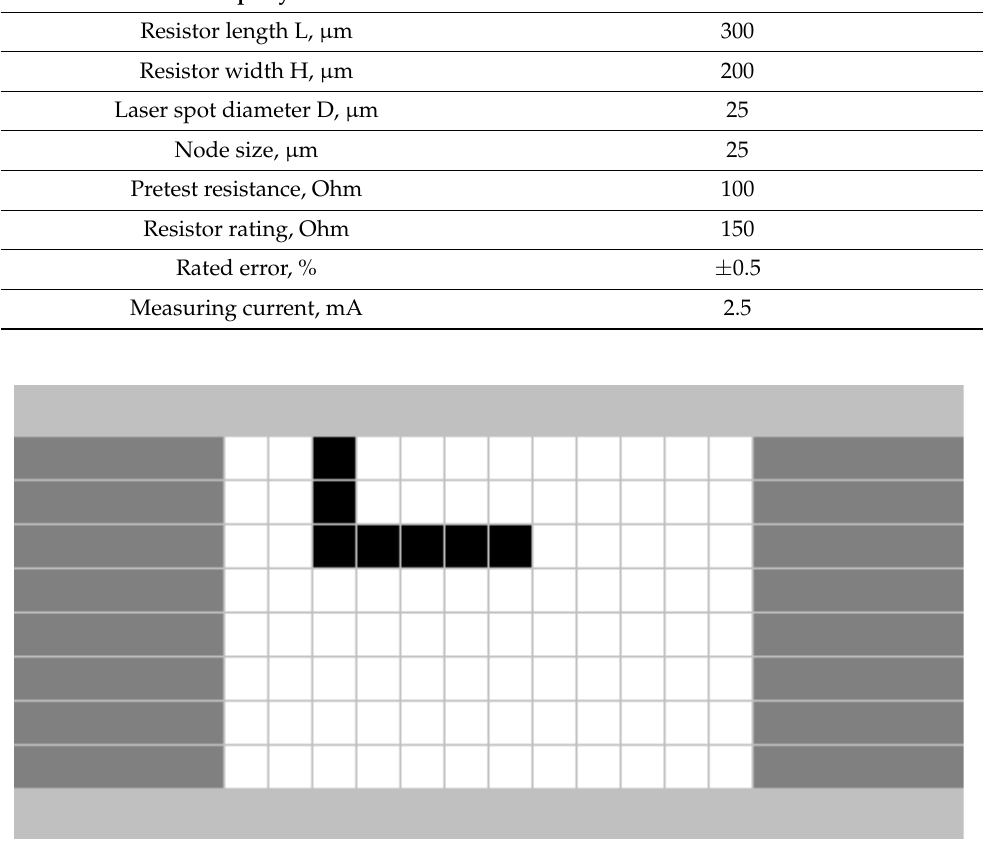
Figure 2. General view of the resistor simulation model.